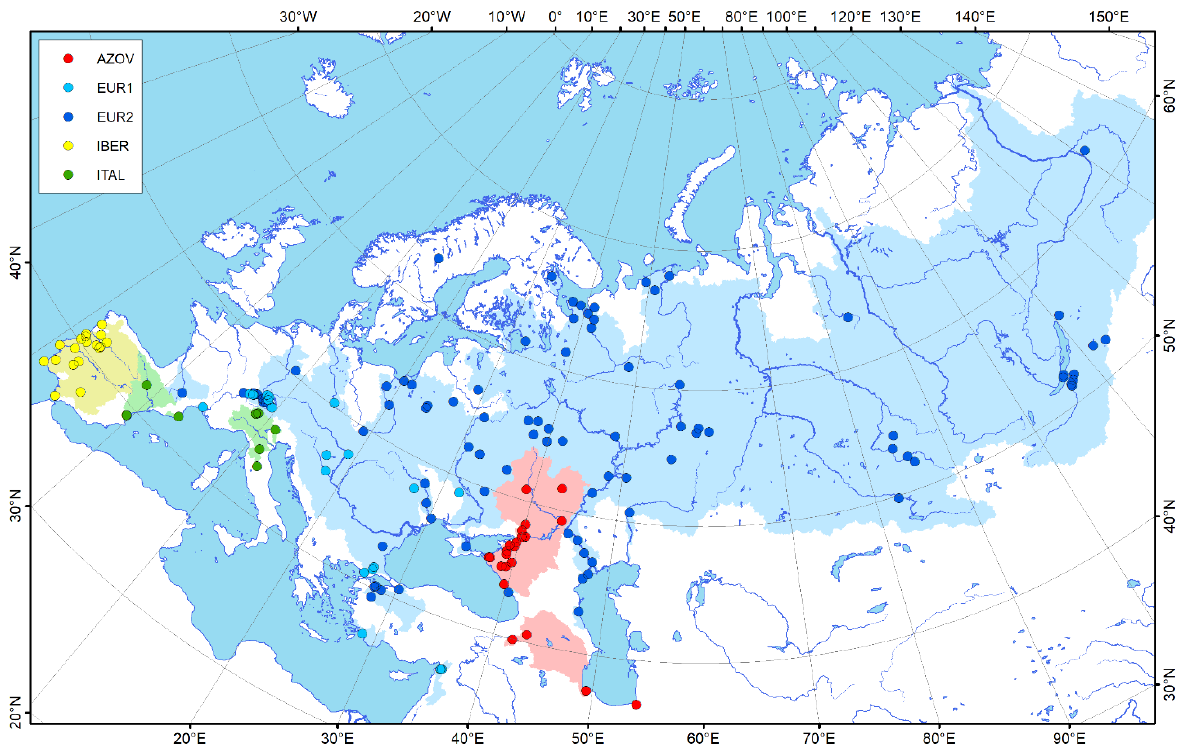
Figure 1. Sampling localities of Anodonta anatina in freshwater basins of Eurasia (our data and samples from NCBI GenBank). Point and freshwater basin colors represent the following lineages: